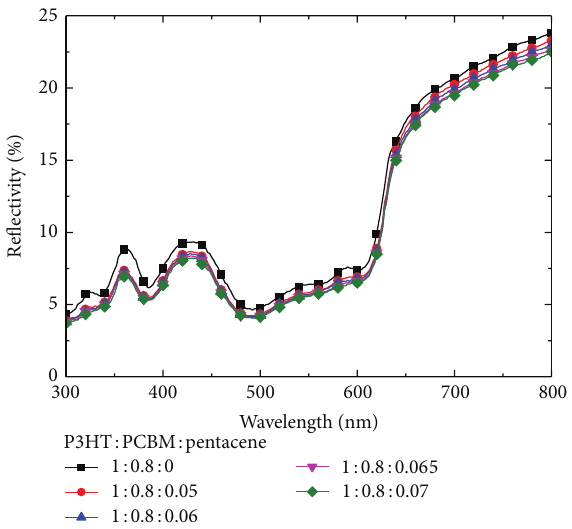
Figure 8: The reflectivity of the inverted PSCs with various pentacene-doped absorption layers.